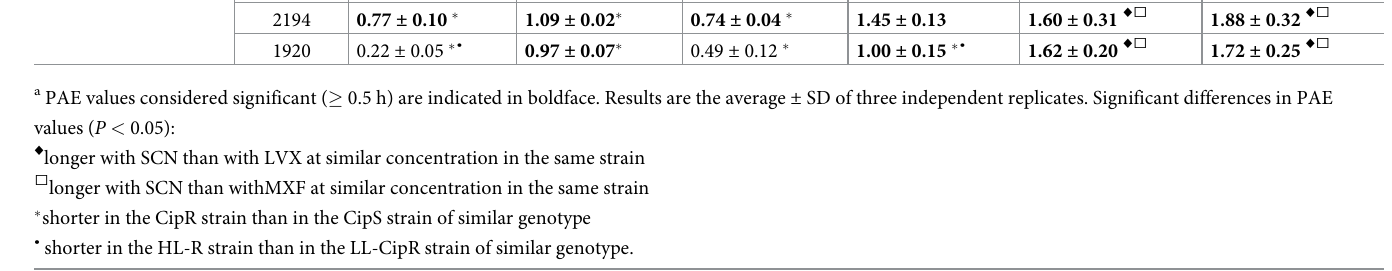
induced a significant PAE at 10 × MIC in all strains (Table 2). However, at 2.5 × MIC no sig- nificant PAE either in the non-encapsulated Cip-resistant strains or in the HL-Cip-resistant R isolate of the ST63 8 clone was induced. PAE induced by MXF were similar or longer than that induced by LVX. PAE induced by either of the two FQs was shorter in resistant strains than in susceptible strains. In contrast, SCN induced significant PAE in all strains at every concentra- tion used and there were no differences between susceptible and FQ-resistant strains. In addi- tion, SCN induced PAEs longer than that induced by LVX and/or MXF (Table 2). The viability of planktonic bacteria in PAE phase was estimated for the R6 strain by fluores- cence microscopy (Fig 2). Treatments of 1 h with 2.5 − 10 × MIC decreased living bacteria by up to 75–57%, 77–62% and 65–52%, for LVX, MXF and SCN, respectively, whereas in control cultures these values were of up to 80% (0 h in Fig 2). Four hours after finishing the treatment (4 h in Fig 2), an increase in live bacteria close to the control values was observed for the FQs, but not for SCN (74–68%). Therefore, SCN treatment was the most effective in reducing bacte- ria viability, not only when the antibiotic was present but also after removing it.